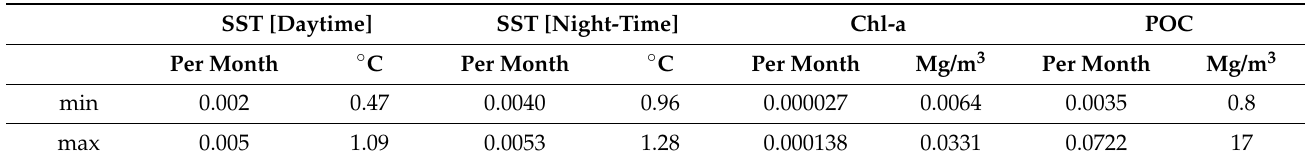
Table 1. Monthly average minimum and maximum slope for physicochemical variables, as extracted by the satellite products, for the whole study area and their corresponding increase during the twenty